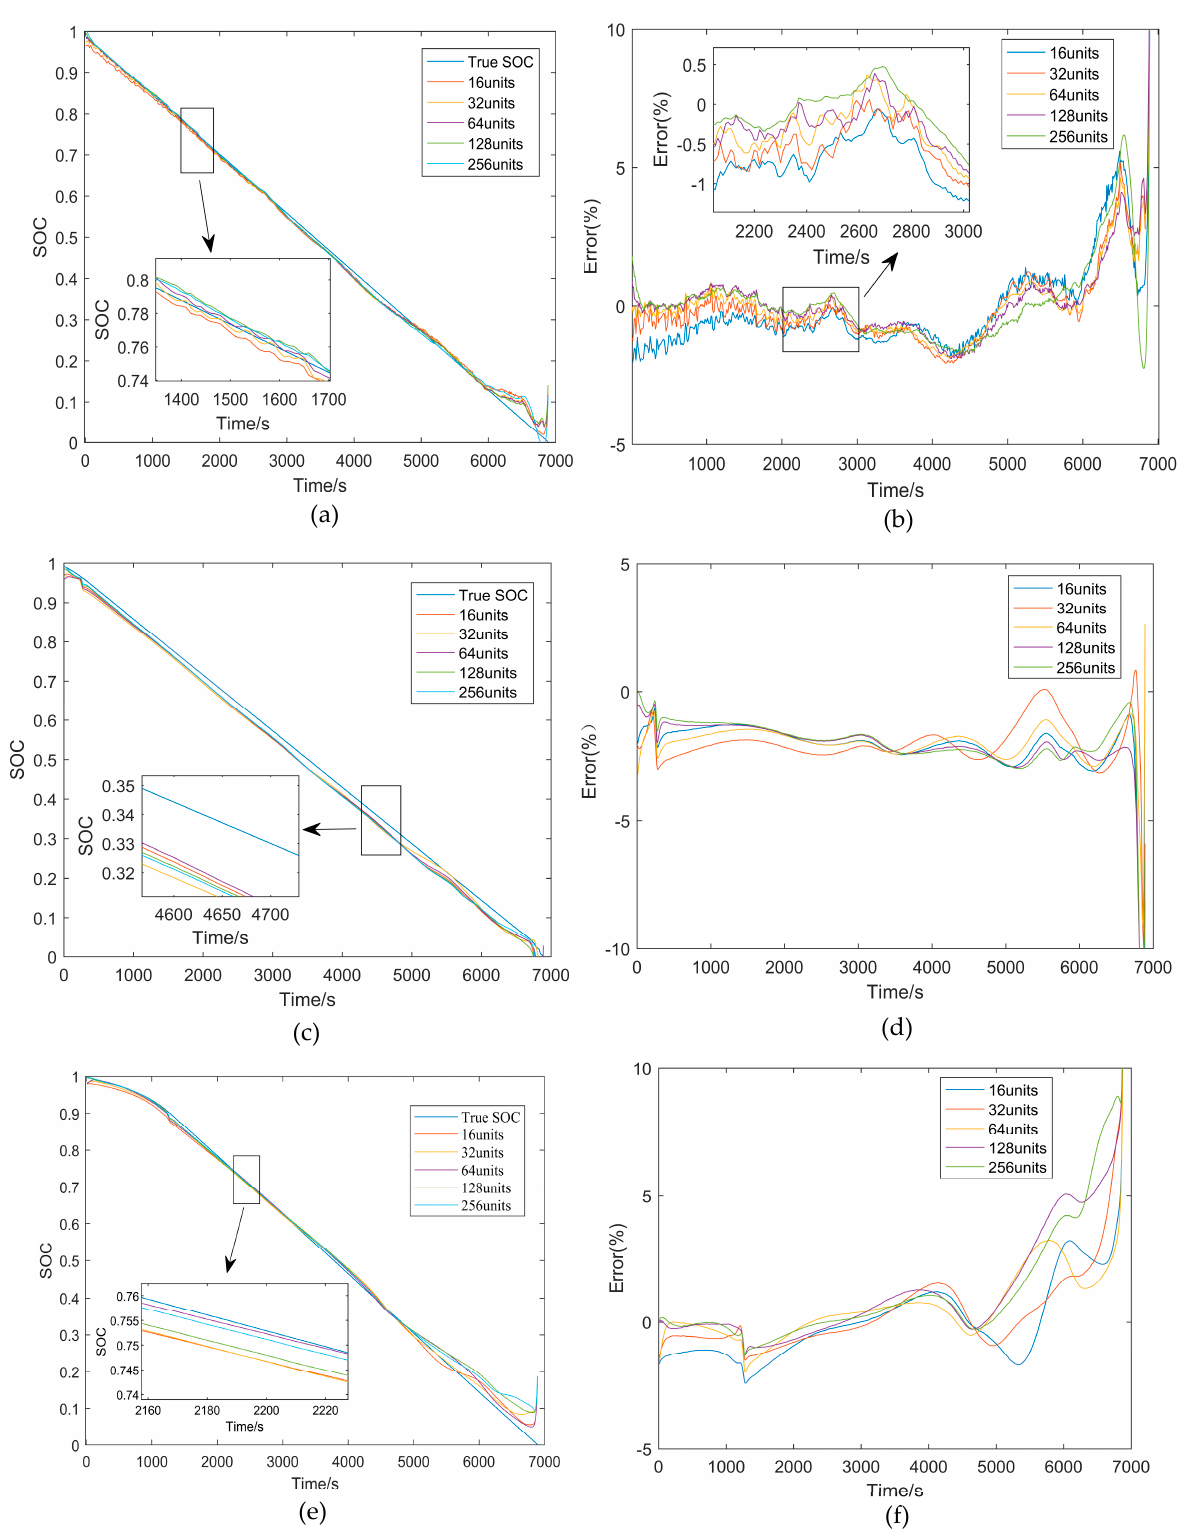
Figure 6. Estimation results and errors of five BiLSTM models based on different numbers of hidden layer units.